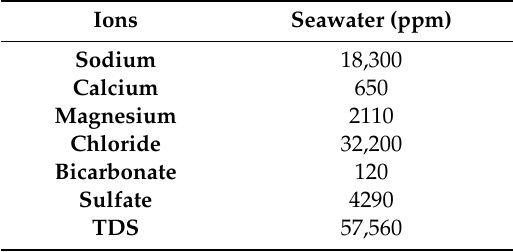
Table 2. Chemical composition of laboratory-made seawater.